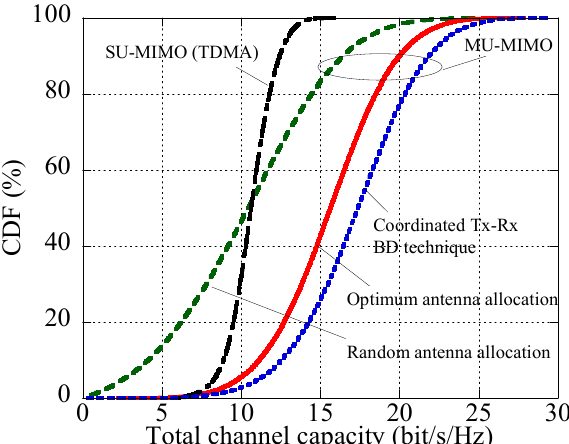
Figure 5. Cumulative distribution function (CDF) of the total channel capacities of the coordinated transmitter-receiver (Tx-Rx) BD technique, MU-MIMO-OFDM transmission with optimum/random antenna allocations, and single user MIMO (SU-MIMO) transmission on the time division multiplexing access (TDMA).